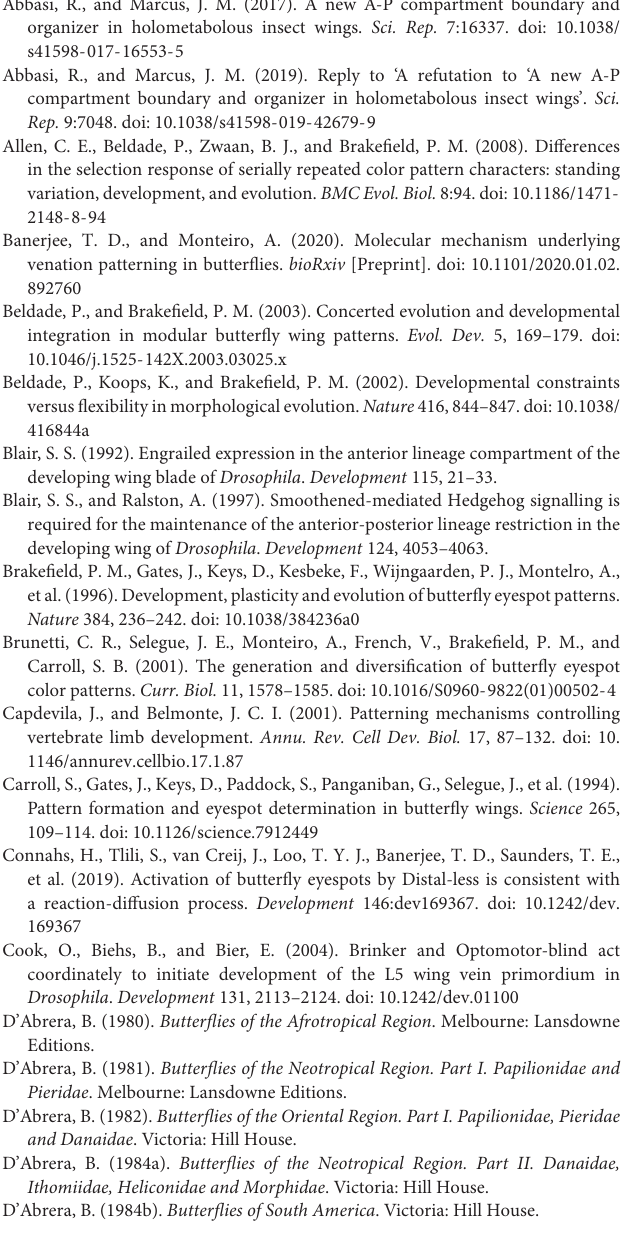
FIGURE S1 | Border ocelli modularity differs between Nymphalidae and Satyridae. Heatmaps of correlations between the relative distance from the wing margin of border ocelli in Satyridae and Nymphalidae. Dark red colors indicate strong correlations. Light red, white, and blue represent weaker